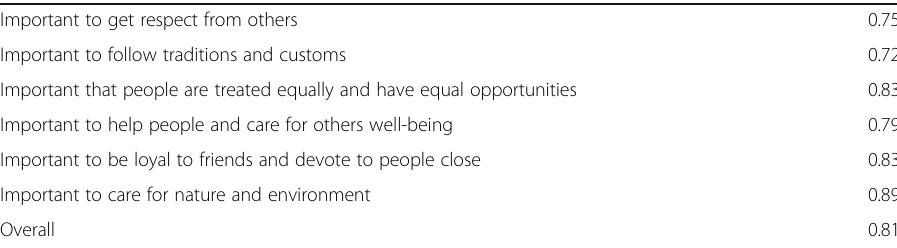
Table 9 KMO test for mastery vs harmony Important to get respect from others